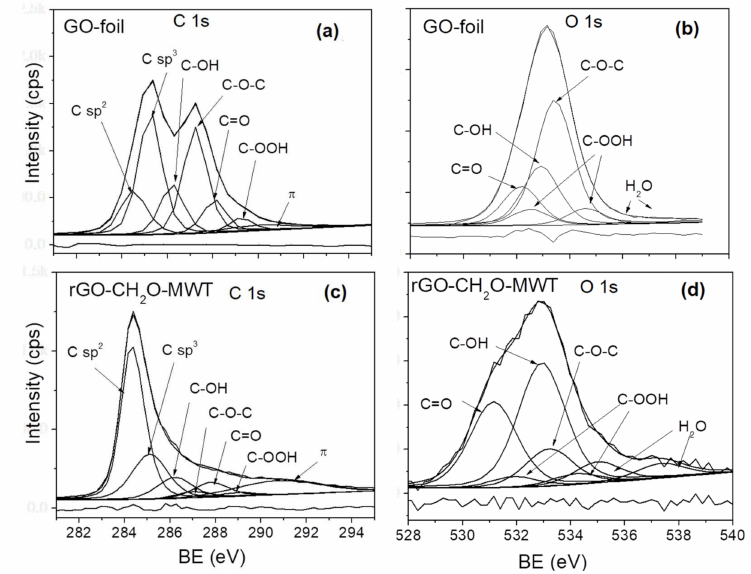
Figure 7. The C 1s and O 1s XPS spectra fitting using asymmetric Gaussian-Lorentzian function for the selected GOs and rGOs. ( a , b ) GO-foil, ( c , d ) rGO-CH 2 O-MWT.